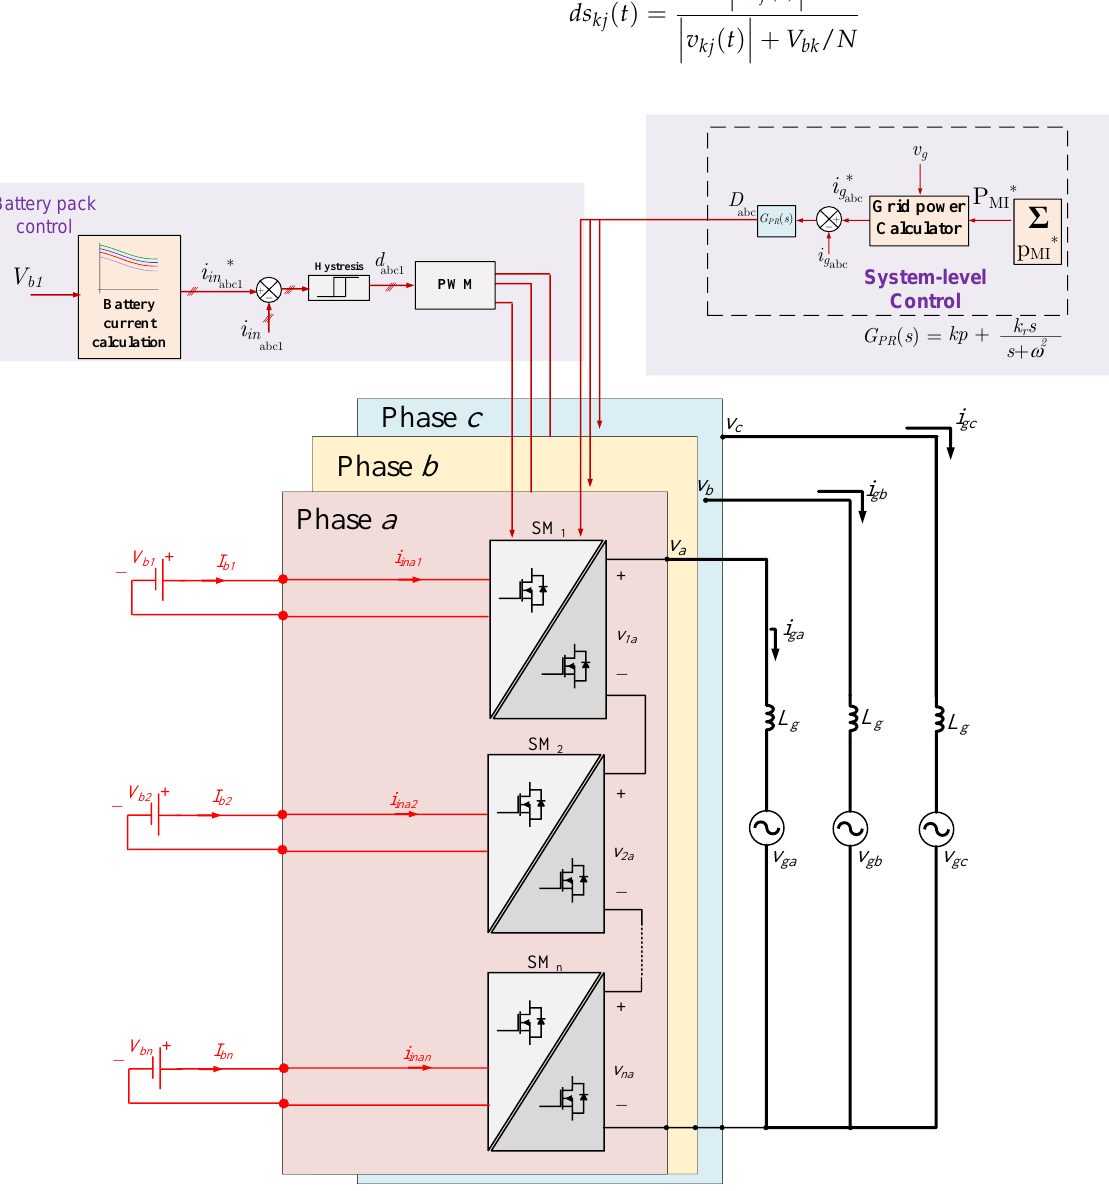
Figure 20. SM control during Mode 3 (from batteries to grid). The duty–cycle ratio of each Cuk inverter ds kj is the summation of d kj and D j . Figure 21 shows the operation for phase a, where the duty–cycle ratio D a is responsible for generating the output voltage and, hence, current. The other duty–cycle ratio d ka controls the input currents of the Cuk inverters according to the input voltages. The tuning process is more complicated for the grid-connected modes. The input currents of the SMs are controlled by a simple hysteresis controller, while the output side is controlled by a proportional resonant (PR) controller, which is tuned according to the SM small-signal transfer function between the output current and the input